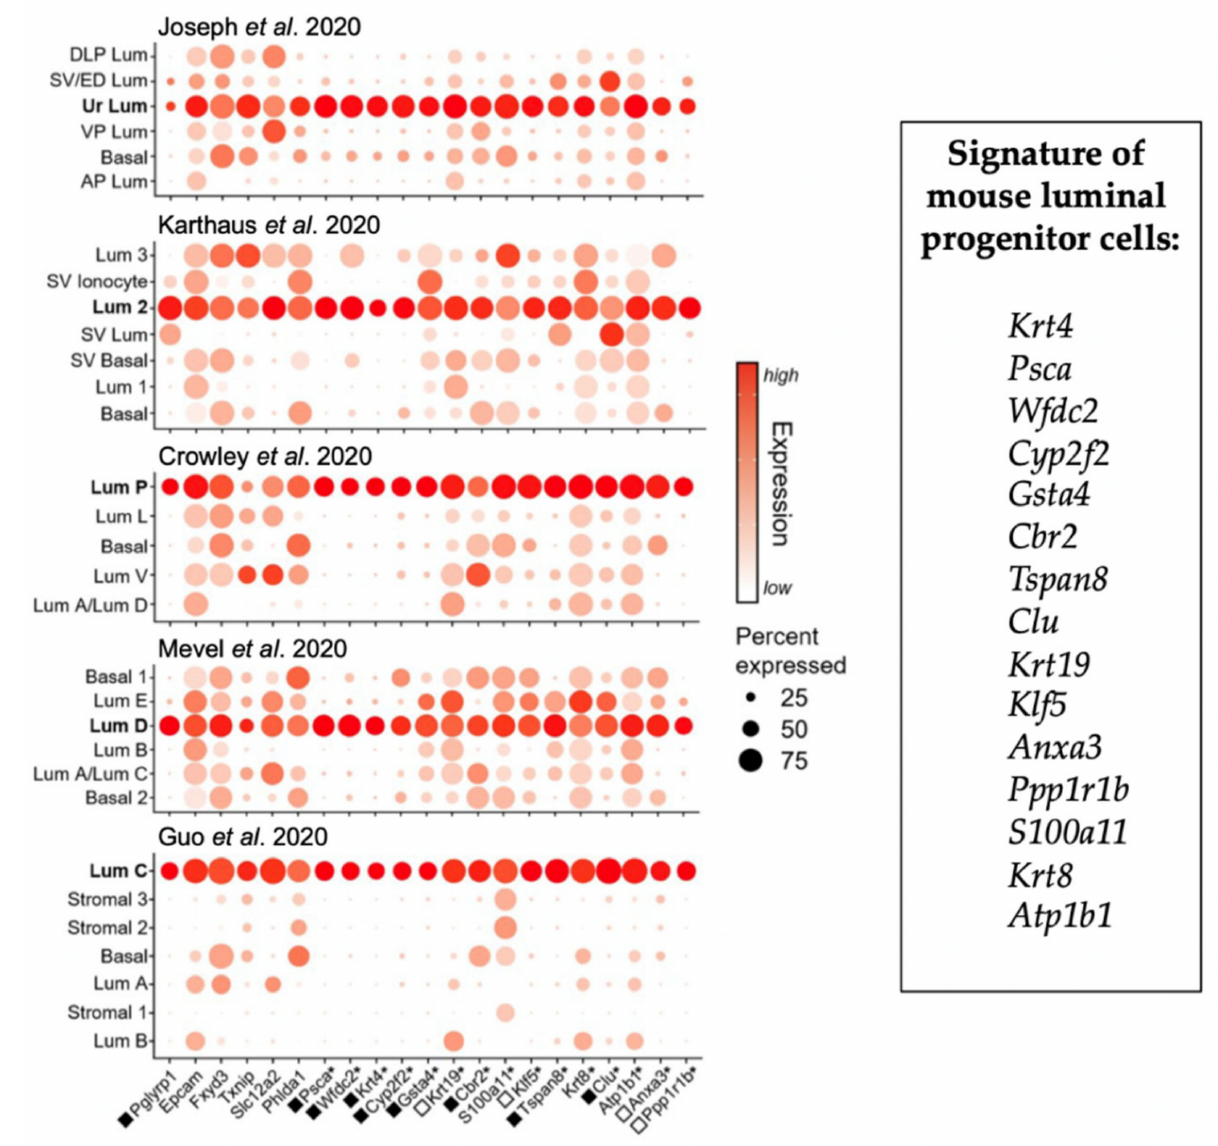
Figure 2. Common markers of luminal progenitors identified by scRNA-seq study of WT mouse prostate. Dot plot representation of marker genes for luminal progenitor cell subpopulations found in the five scRNA-seq studies discussed in the text [10,14–17], showing their relative expression across all detected clusters. Each dot depicts both detection rate and average gene expression in detected cells for a gene in a cluster. Darker red colors indicate higher average gene expression, and a larger dot diameter indicates that the gene was detected in greater proportion of cells from the cluster. Stars (*) depict the 15 marker genes detected in all datasets that constitute the mouse luminal progenitor cell signature. Squares indicate marker genes that were significantly ( p < 0.05) identified in the LSC med cell signature using 1.5 (black) or 1.2 (white) fold-change [5]. The other genes were all expressed in LSC med cells at similar levels as in basal and/or luminal cells, and therefore, they were not identified as LSC med cell markers. AP, anterior prostate; DLP, dorsolateral prostate; ED, ejaculatory duct; Lum, luminal; LP, lateral prostate; SV, seminal vesicle; Ur: urethra; VP, ventral